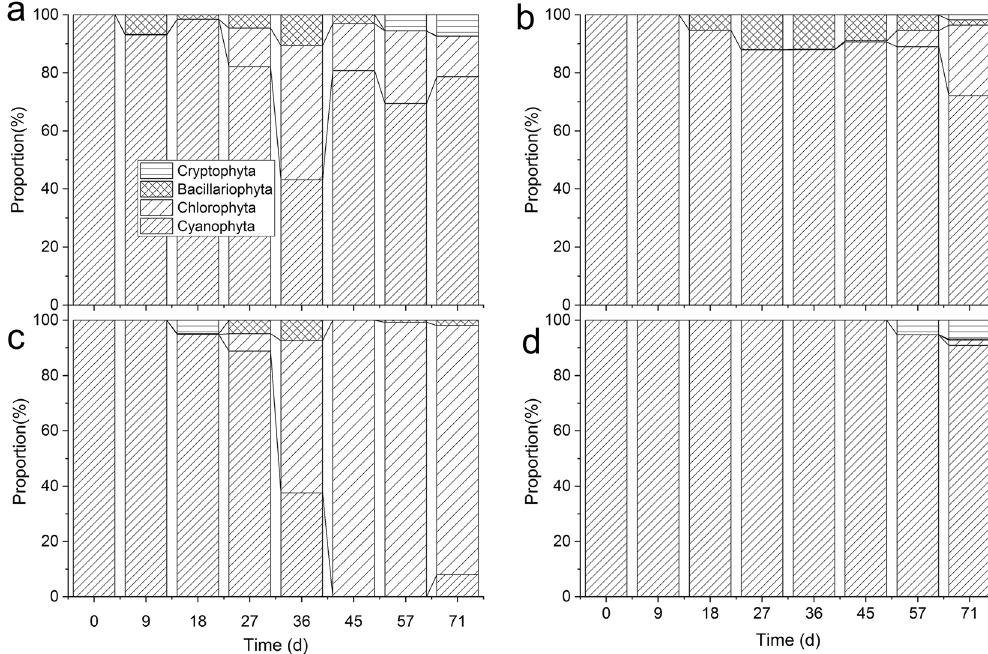
Figure 2. The proprotional contribution of Cyanophyta, Bacillariophyta, Chlorophyta, and Cryptophyta to the total biomass in the control ( a ), treatments Low ( b ), Medium ( c ) and High ( d ) during the